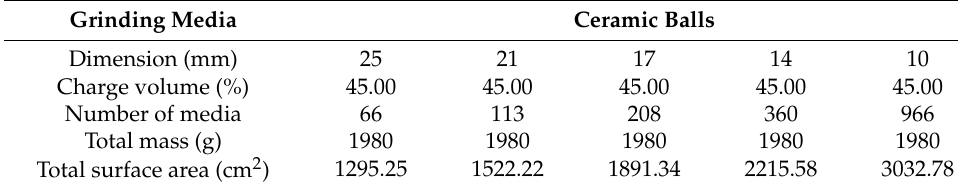
Table 5. Ceramic balls with the same total mass as cylpebs (12 × 12 mm).